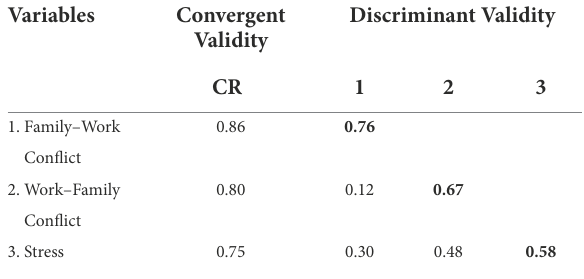
TABLE 2 Construct